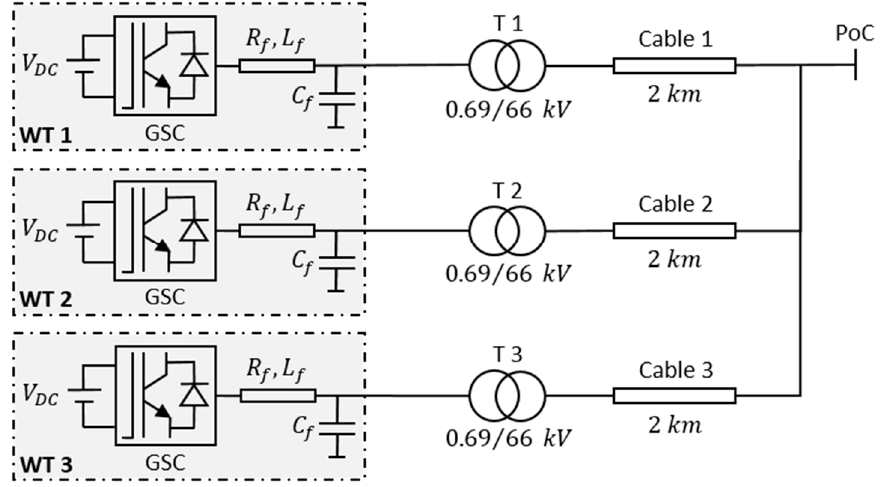
Figure 1. Schematic of a WP.